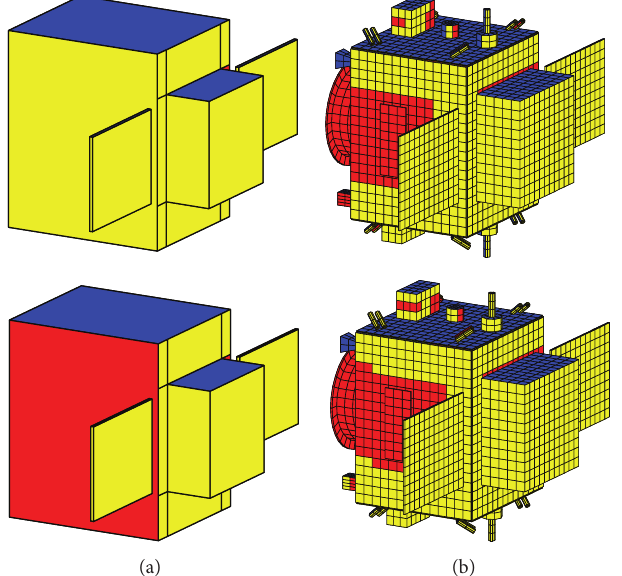
Figure 10: Illumination conditions of Wing-Box model (a) and FE model (b) for different dates of the simulated MICROSCOPE scenario. Upper row: end of April 2016, lower row: a few days later in May 2016. Yellow elements are in full sunlight, blue elements are not exposed to the Sun, and red elements are shadowed by other parts of the satellite.